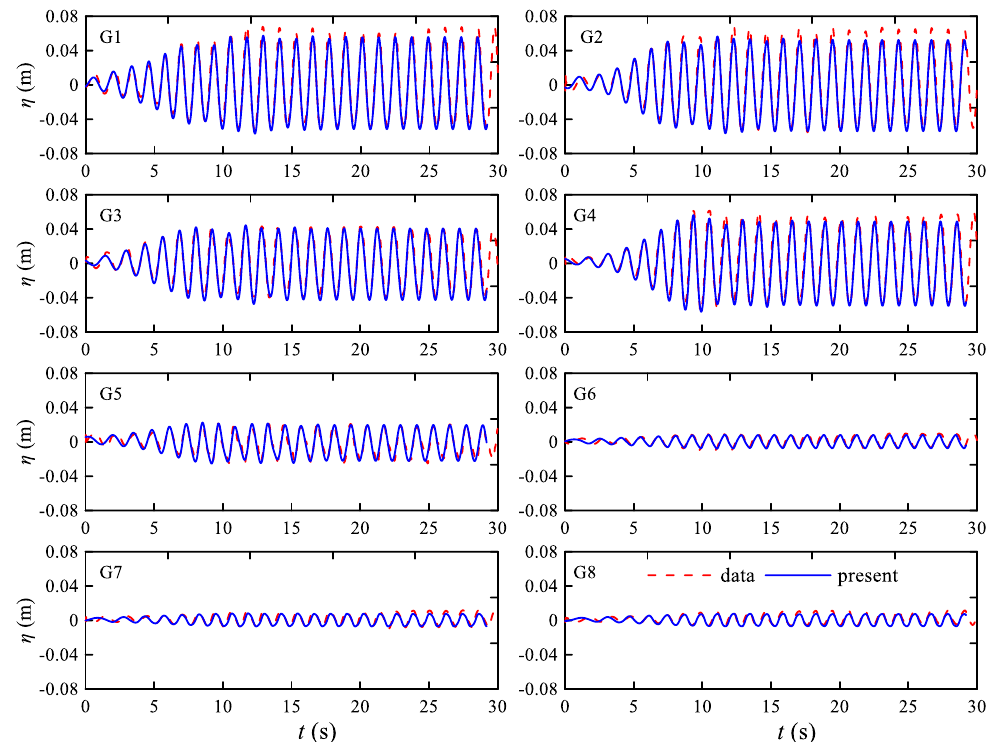
Figure 7. Time series of surface elevation for regular wave propagation in porous structure (Case R1).